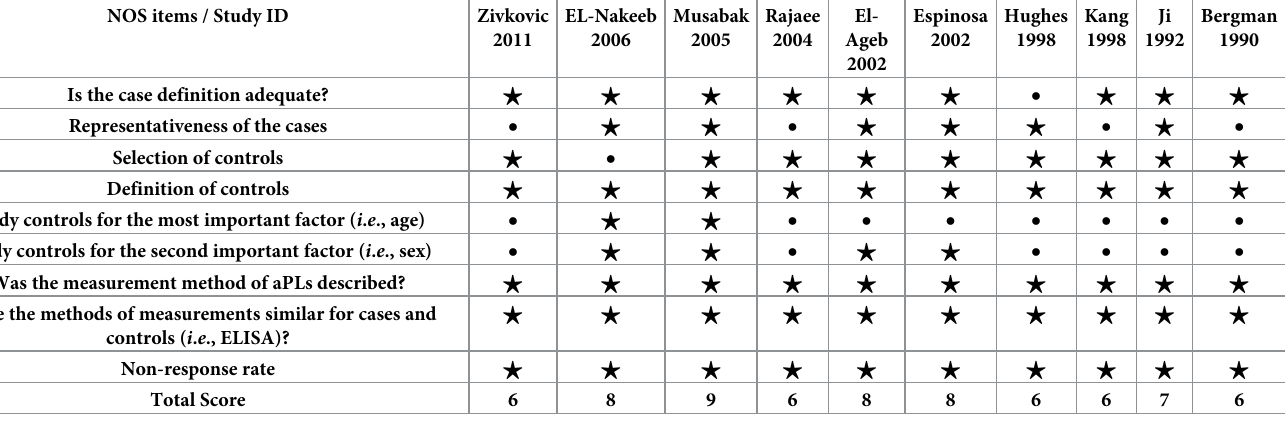
Table 2. Risk of bias assessment of the included studies according to the modified Newcastle-Ottawa Scale